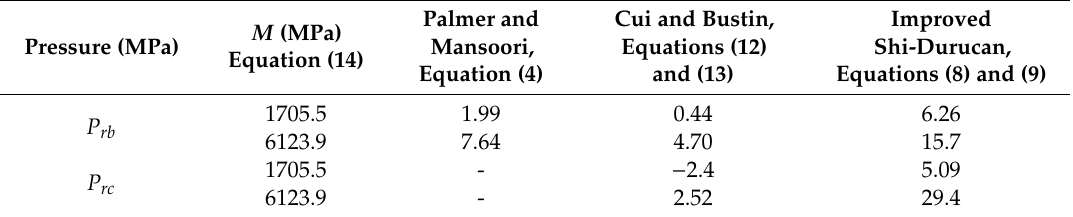
Table 6. The rebound pressure P rb and recovery pressure P rc values for the Palmer and Mansoori, Cui and Bustin, and improved Shi-Durucan models, as obtained for the Boomer well B-1 San Juan basin. 264 Palmer M (MPa) Pressure (MPa) Pressure Equation (14)